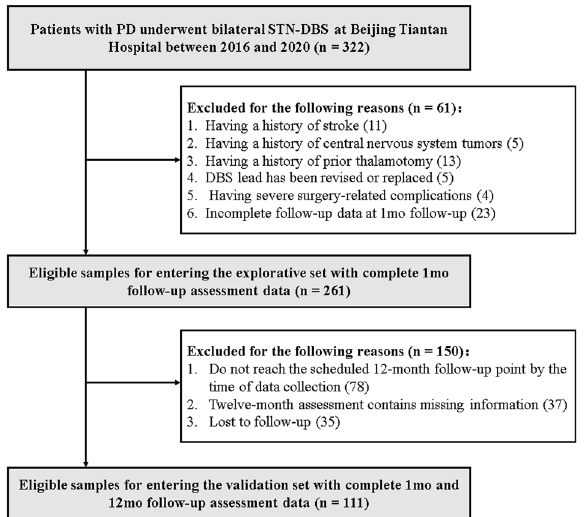
Fig. 1 The work fl ow of participants ’ identi fi cation in the explorative and the validation datasets. PD, Parkinson ’ s disease; STN-DBS, subthalamic nucleus deep brain stimulation.